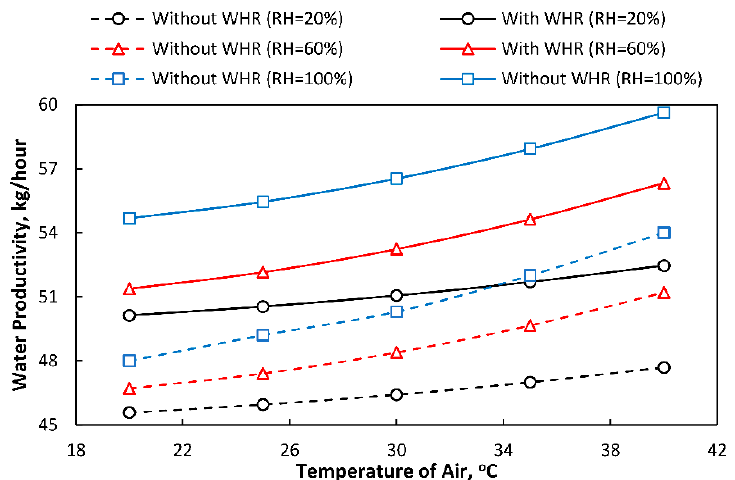
Figure 10. Influence of temperature of the air on freshwater productivity with and without waste heat recovery.